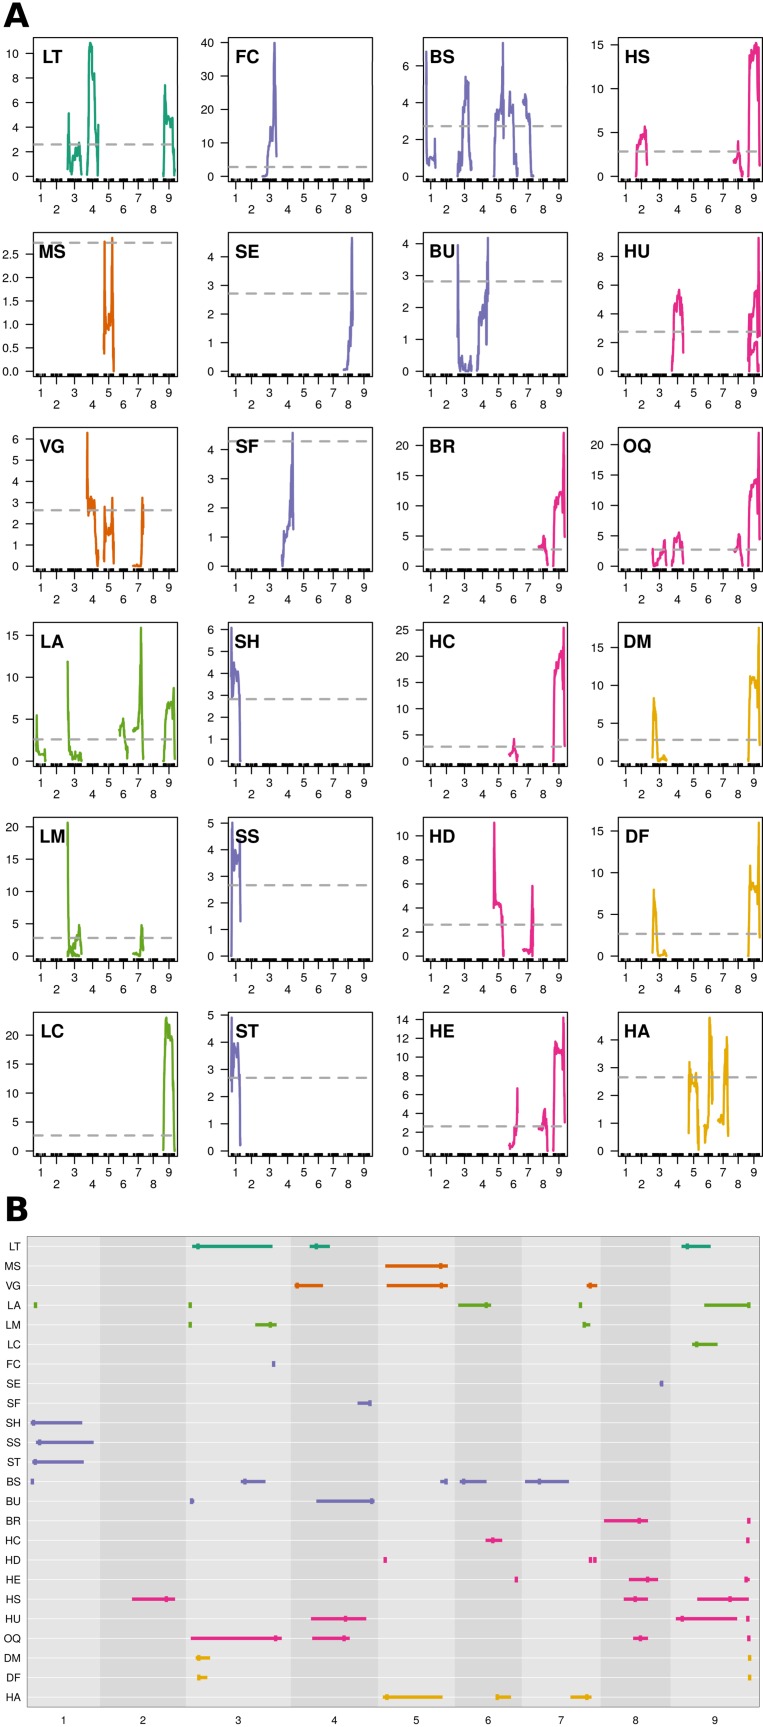
MQM QTL mapping results: (A) QTL plots by trait and chromosome using 1881 markers, 175 double haploid lines, and pooled phenotypes across environments (Y12; X-axis = chromosome, Y-axis = LOD). Horizontal, dashed, grey line = genome-wide significance threshold (α = 0.95) determined from 1,000 permutations of scantwo() for individual traits. Trait class is indicated by color (architecture = dark green, biomass = orange, leaf morphology = light green, bud morphology = light blue, heading quality = pink, and phenology = yellow). (B) Summarized MQM results; traits evaluated in BolTBDH printed along the Y-axis and chromosomes scaled by physical distance (Mbp) are arranged on the X-axis. MQM peak apex given by vertical bar and 95% Bayesian confidence intervals indicated by width of horizontal bar. Color schema is recycled from (A).